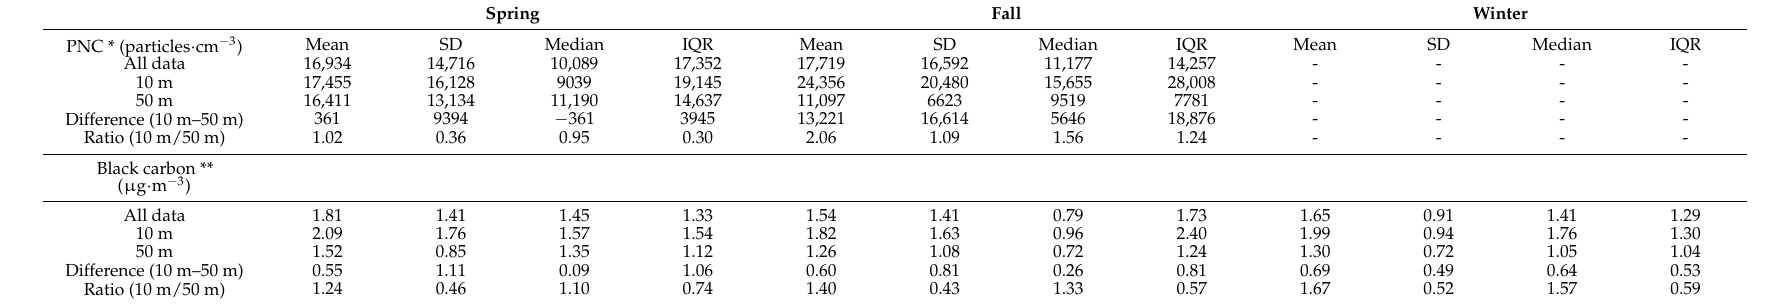
Table 3. Near-highway measurements of particle number and black carbon concentrations alongside the highway and vegetative barrier. PNC * (particles·cm −3 ) Mean All data Spring Fall Winter